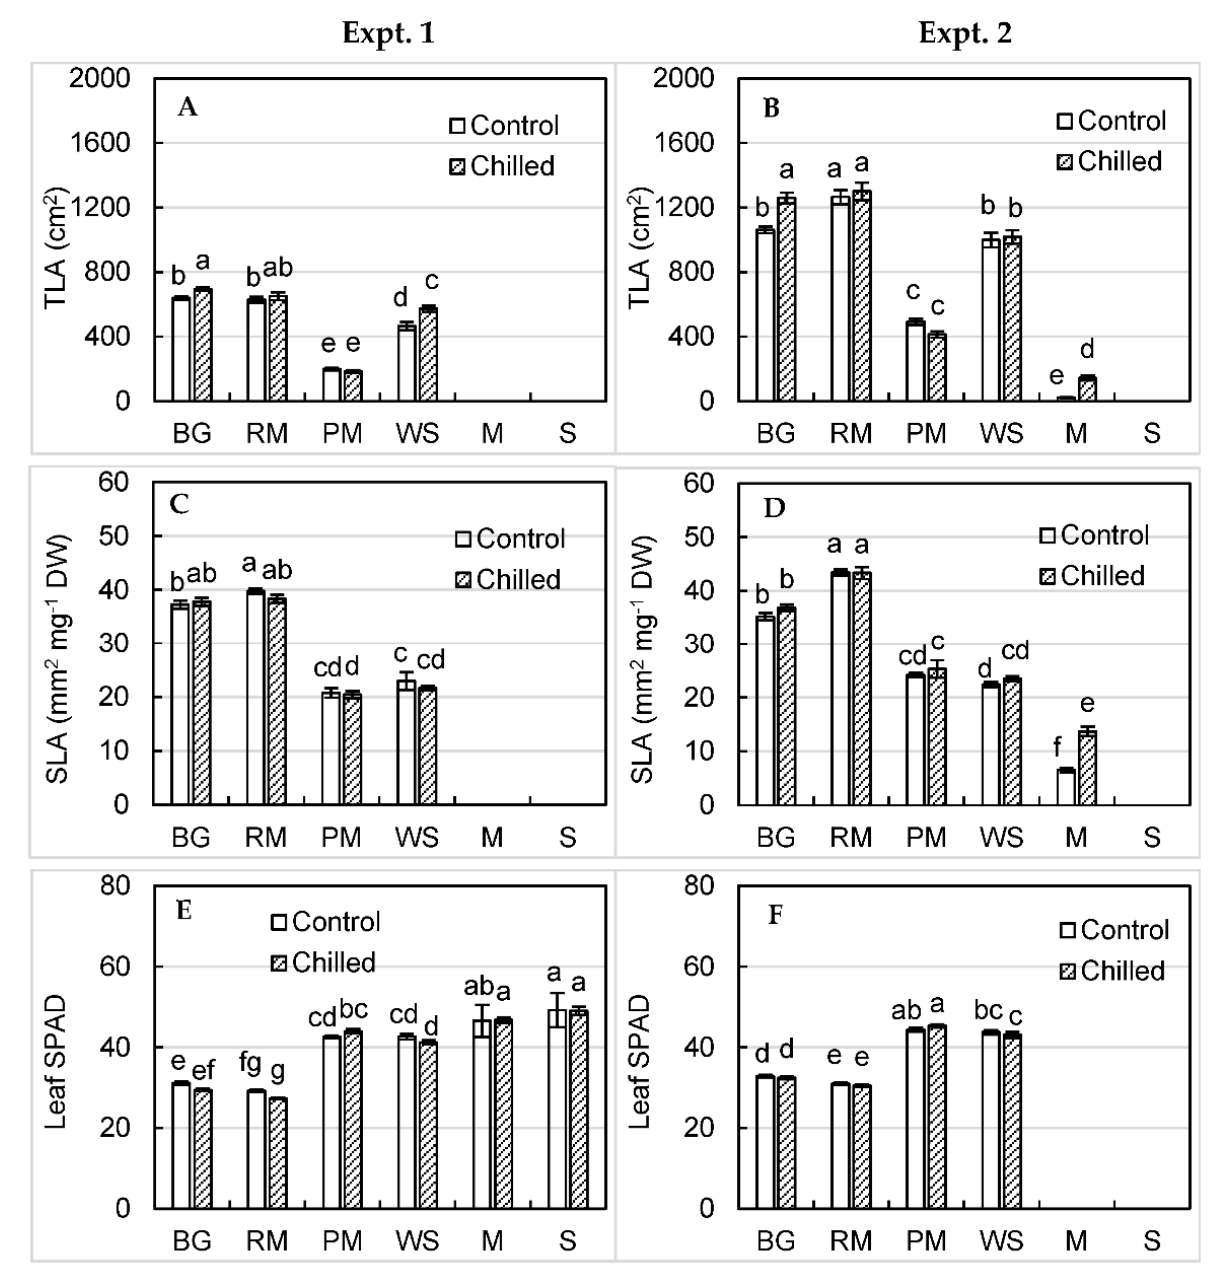
Figure 2. Total leaf area (TLA) ( A , B ), specific leaf area (SLA) ( C , D ), and leaf relative chlorophyll content (SPAD) ( E , F ) of the lettuce varieties ‘Bergam’s Green’(BG) and ‘Red Mist’ (RM), Pak Choi varieties ‘Purple Magic’ (PM) and ‘White Stem’ (WS), and spinach ( Spinacia oleracea L.) ‘Mandolin’(M) and ‘Seaside’ (S) grown in a deep-water culture hydroponic system with nutrient cooling or no cooling (Control). Different letters represent significant differences between treatments according to Tukey’s HSD test ( p <